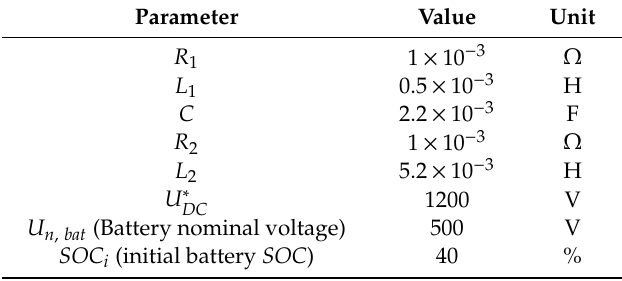
Table 3. Main parameter values for the simulation of the three-phase